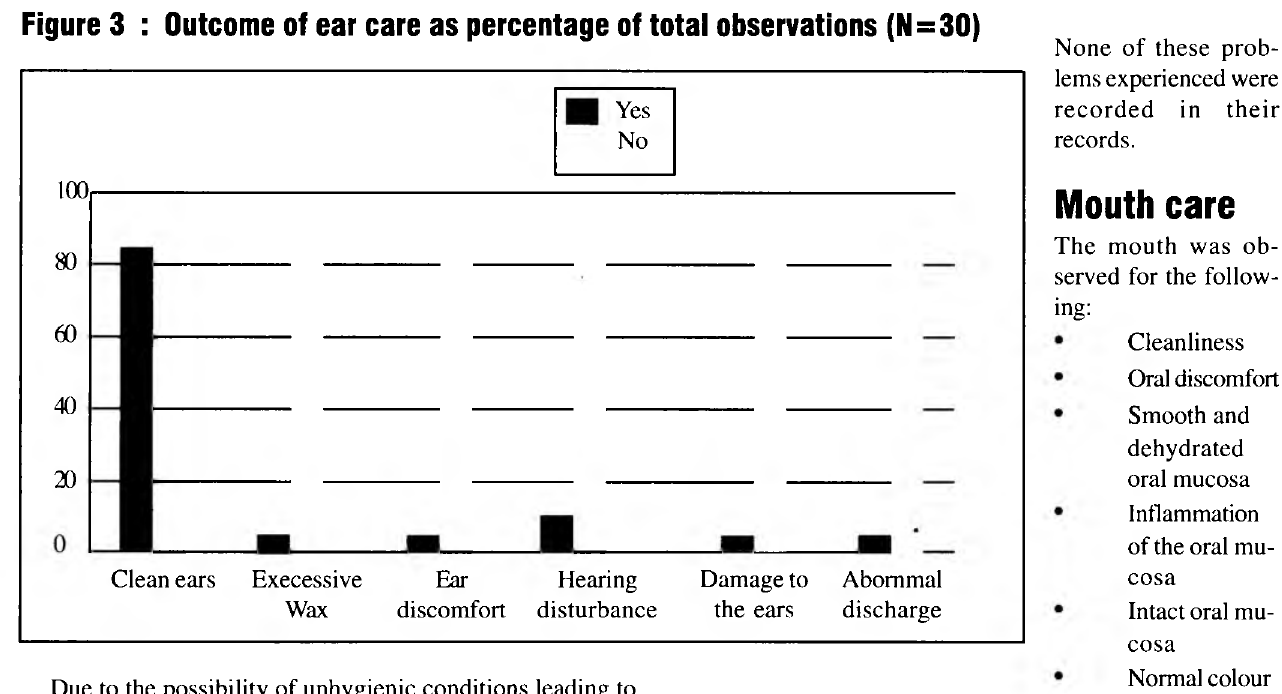
Figure 3 : Outcome of ear care as percentage of total observations (N=30)